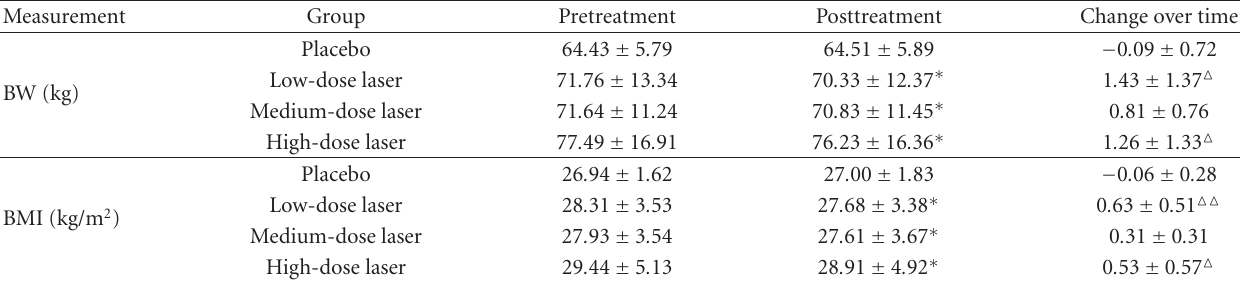
Table 1: Body weight and body mass index data in the placebo group and the three laser groups before and after treatment. Measurement Group Pretreatment Posttreatment Change over time Placebo 64 . 43 ± 5 . 79 Low-dose BW (kg)